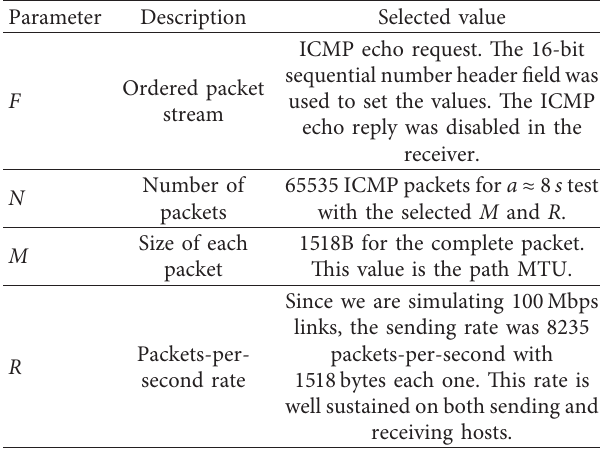
Table 3: Parameters to be configured to perform the reorder